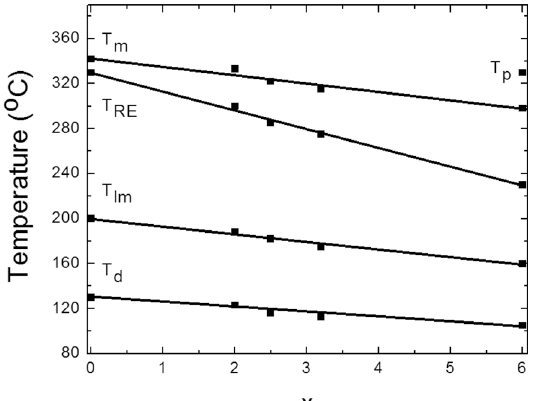
Figure 2. The plot of downs the phase transitions temperatures detected by acoustic emission in Na ferroelectrics crystals in dependence on x